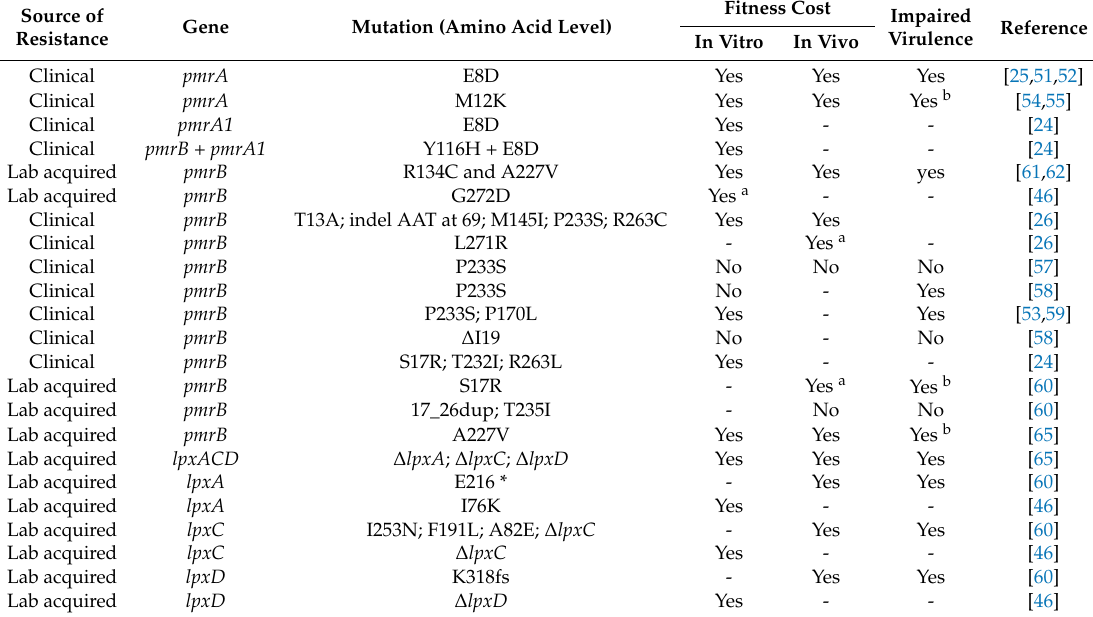
Table 1. Studies showing mutations present in well-known colistin-resistance genes and fitness cost and virulence observed in